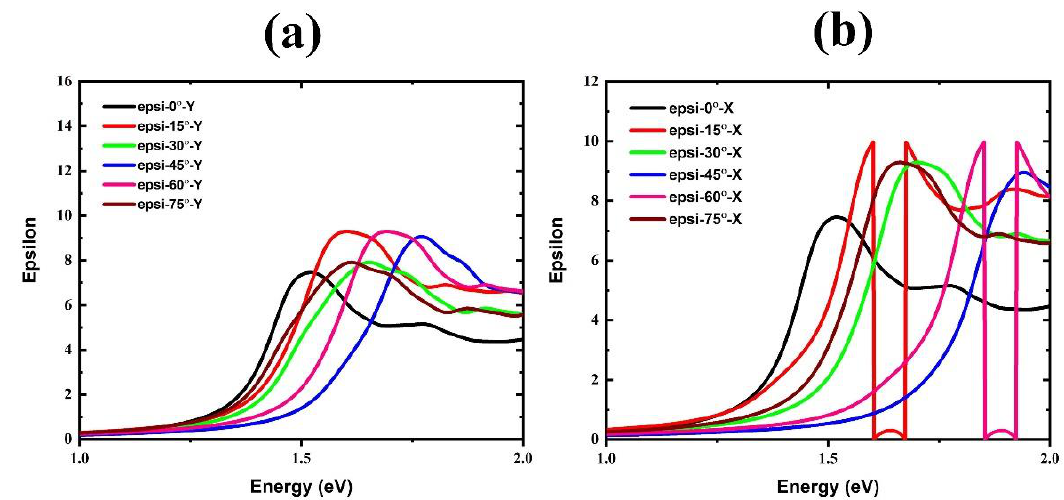
Coatings 2021 , 11 , x FOR PEER REVIEW 10 of 15